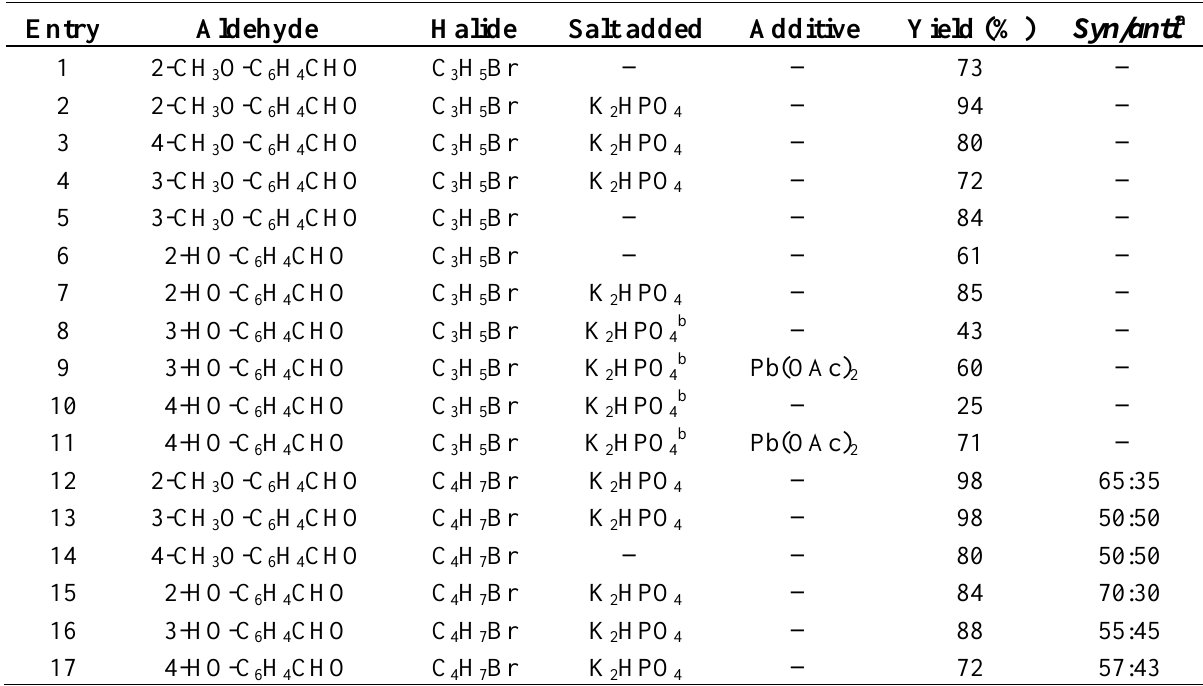
Table 1. Tin-mediated allylation of oxy-substituted benzaldehydes in aqueous media. Entry Aldehyde